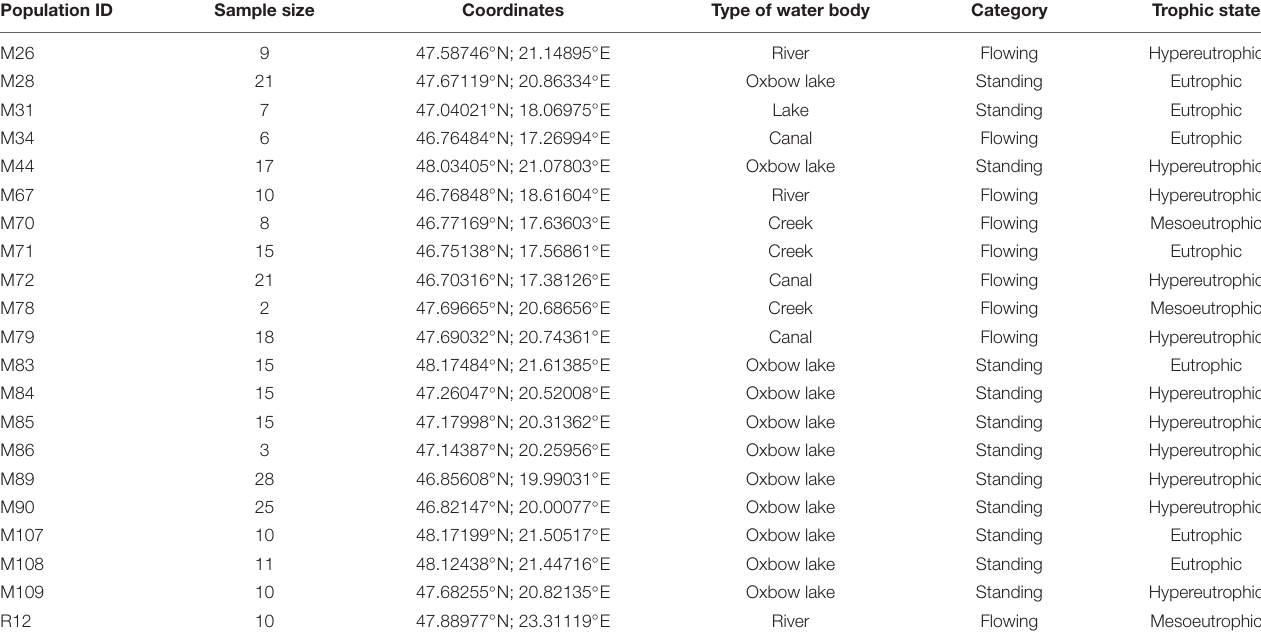
TABLE 1 | Location, sample size, type and trophic state of water bodies from which Hydra polyps were collected[1]. Population